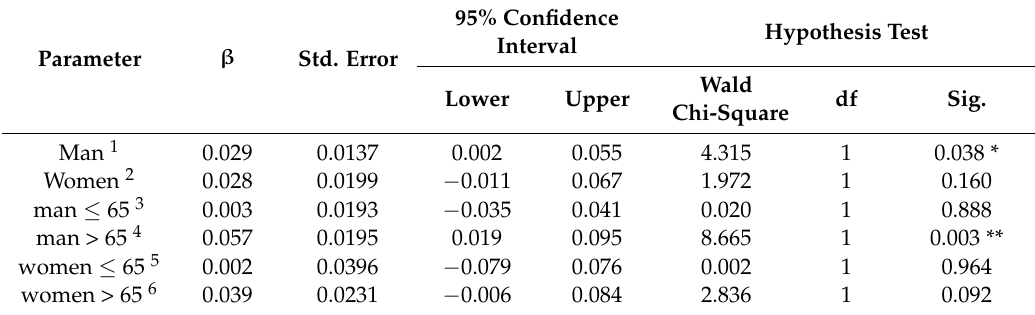
Table 2. Immediate daily ACS incidence change per 10 µ g/m 3 PM 10 increase for the population grouped by gender and